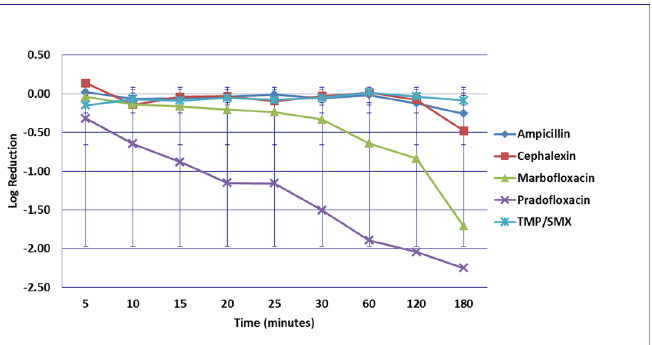
Figure 14. Log 10 reduction in S. pseudintermedius with bacterial cells exposed to cephalexin, mar- bofloxacin, and pradofloxacin at the mutant prevention drug concentration. Data points present mean ± standard deviation.